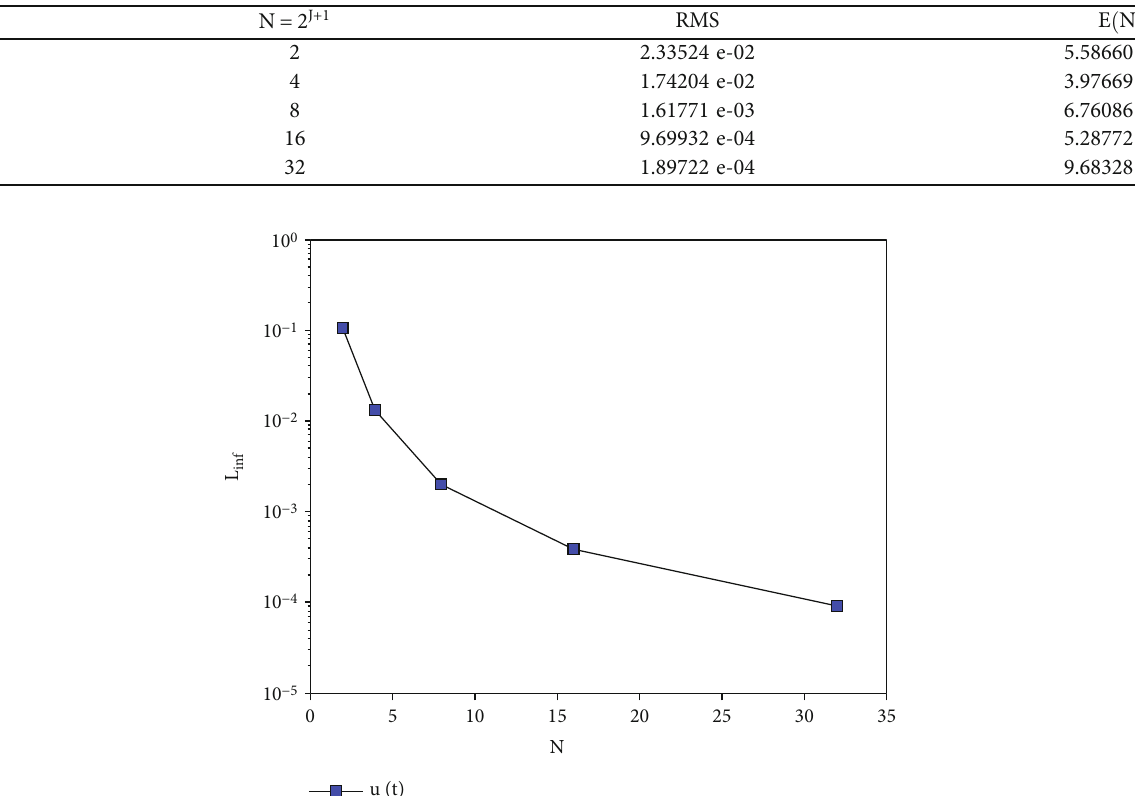
Table 3: RMS and E ð N Þ errors for Example 3.